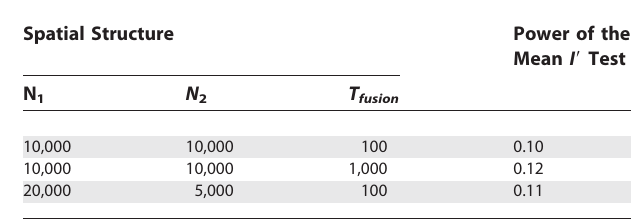
Table 4. The Power of the Mean I 9 Test to Detect Tree Imbalance under a Model of Population Merging Spatial Structure Mean I 9 Test